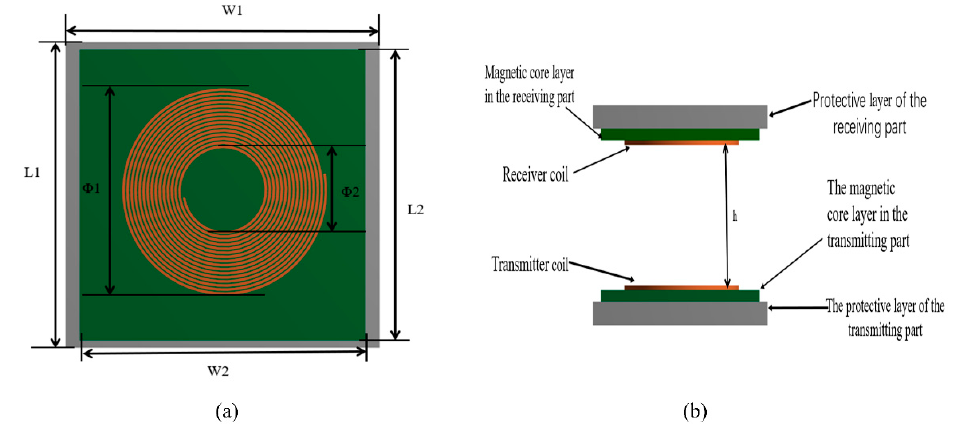
Figure 6. Coil model view. (a) Top view of the coil model Figure, (b) Side view of the coil model.